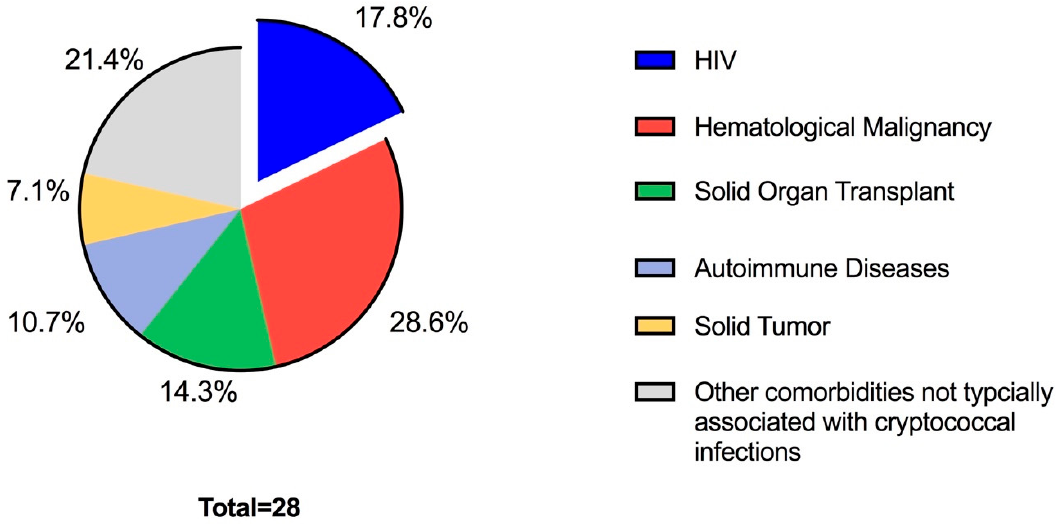
Figure 1. Percentage of the total number of cryptococcal infections represented by each underlying comorbidity.